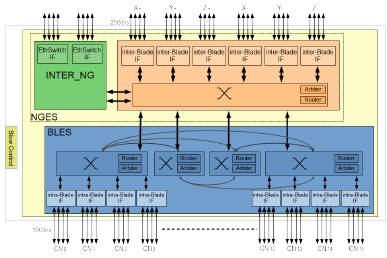
Figure 7. EuroEXA Custom Switch block dia- gram option 2.